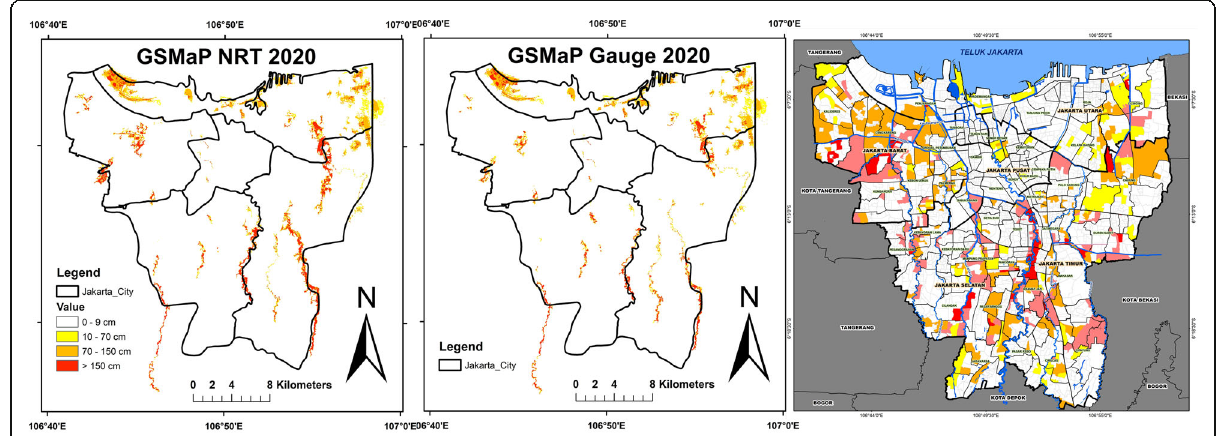
Fig. 17 Flood inundation comparisons for flood event of 2020